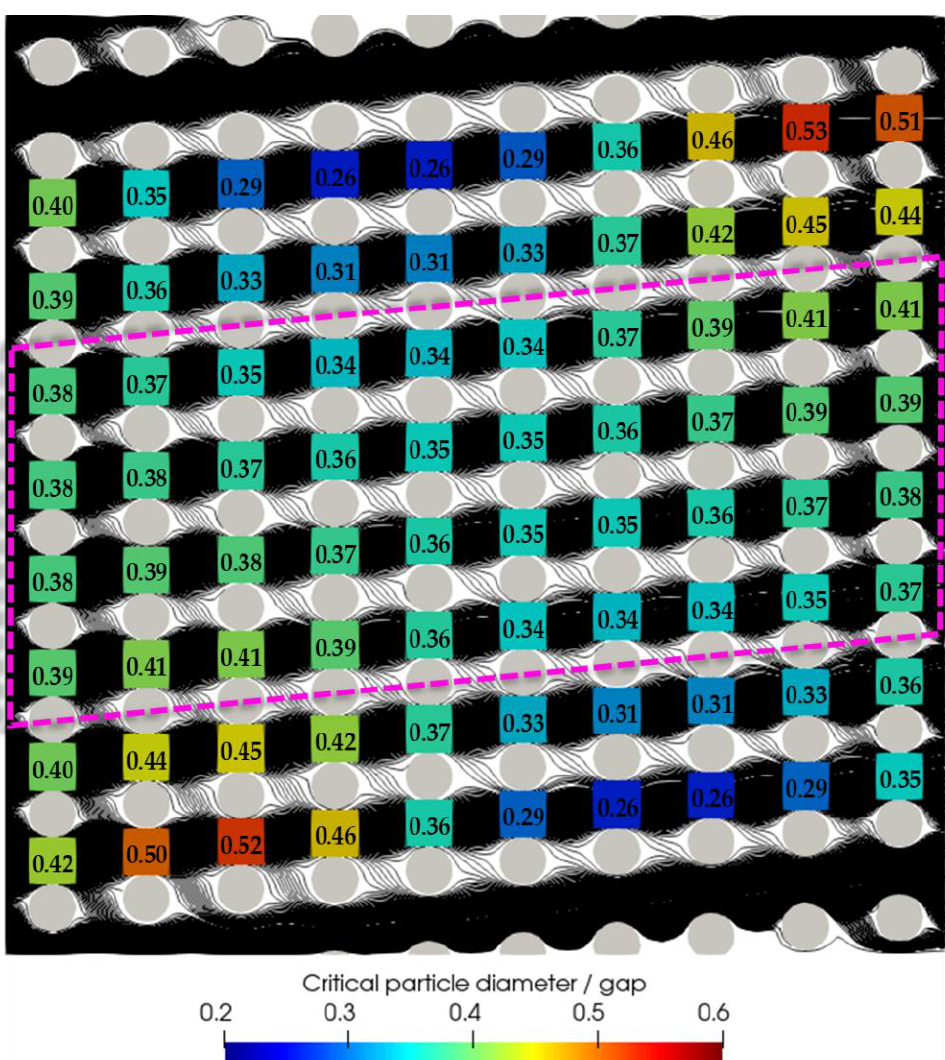
Figure 4. The figure shows the streamlines within the simulation case at Re = 1 and H / G = 1. It can be seen that, as noted by Pariset et al. [58], in the sections where posts and wall intersect, the streamlines tend to be directed away from the wall, and in the sections where the wall does not intersect posts, the streamlines tend to be directed towards the wall. By means of the local fluidic periodicity and the corresponding local flow profiles, the distribution of the critical particle diameters, d c , divided by the gap was determined and color-coded. The dashed purple line was used to mark which values were used for the d c distributions, as the particle only remains in this area and, therefore, the surrounding areas are irrelevant for the comparison to particle trajectories.